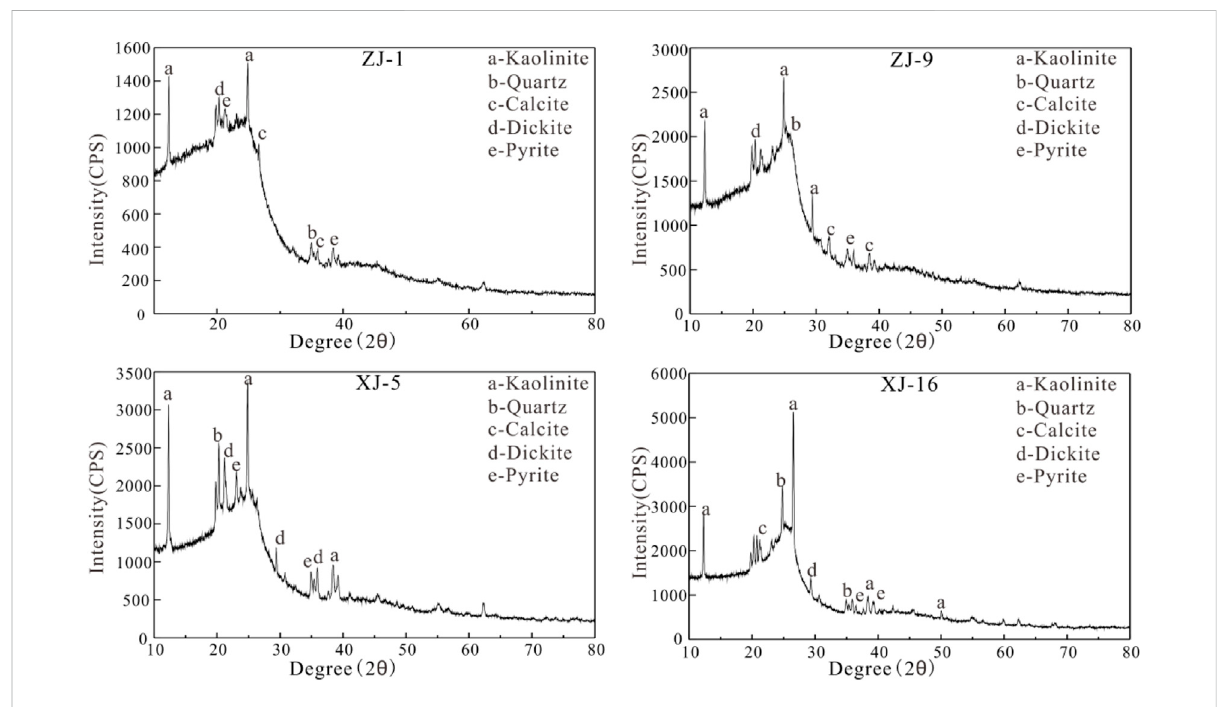
FIGURE 2 X-ray diffraction spectrum of coals in the Shanxi Formation.